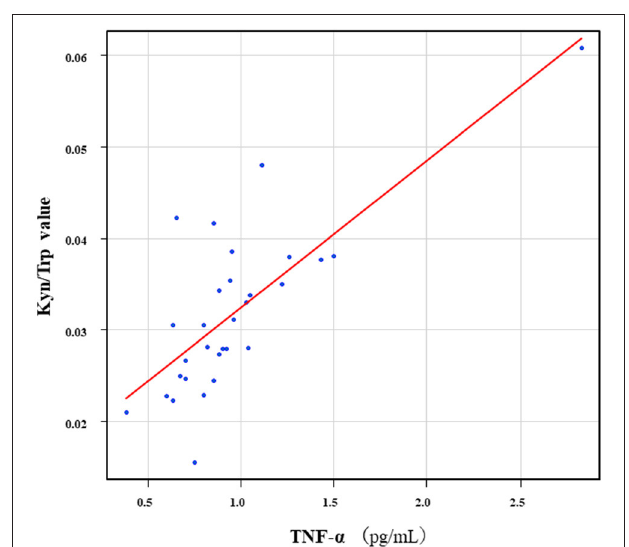
FIGURE 2 | Association between serum TNF- α levels and the Kyn/Trp value in the schizophrenia group. A significant positive correlation was found between the serum TNF- α levels and the and the Kyn/Trp value ( r = 0.67, p = 0.000046) in the schizophrenia group.